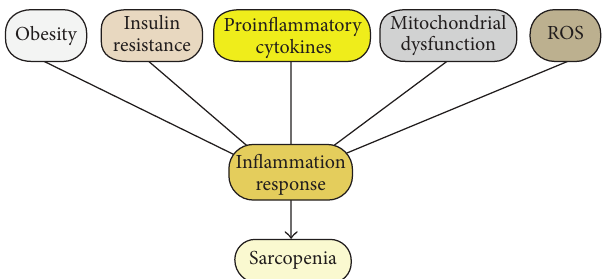
Figure 1: The interplay between sarcopenia and chronic inflam- mation. The boxes represent domains known to influence the maintenance of sarcopenia and inflammation response in aging organisms. Abbreviations: ROS, reactive oxygen